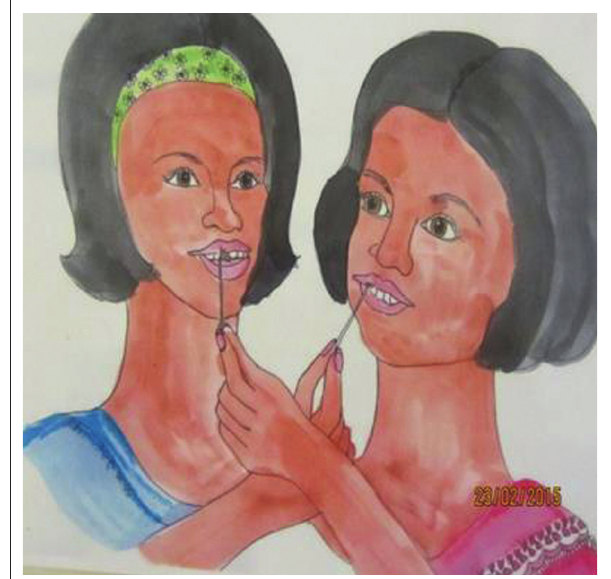
FIGURE 8: Two women picking meat or food morsels from each other’s teeth.